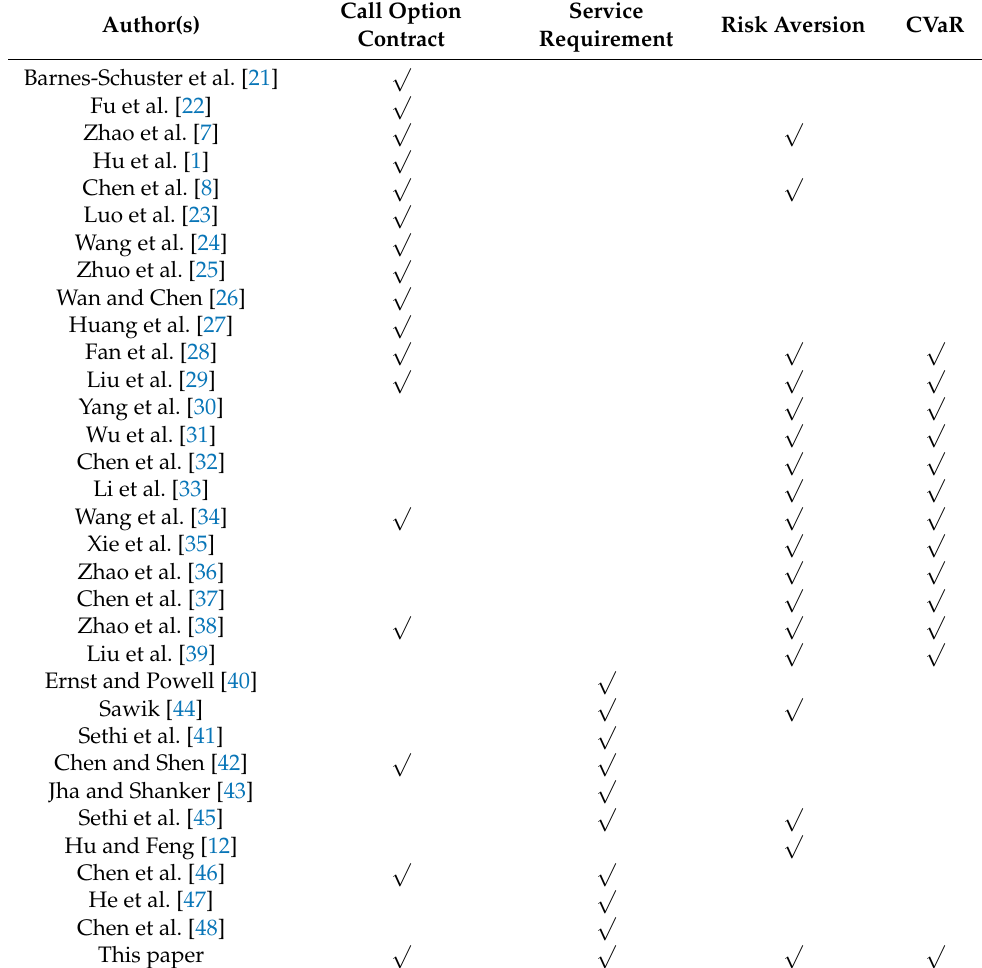
Table 1. Comparison with contributions of different